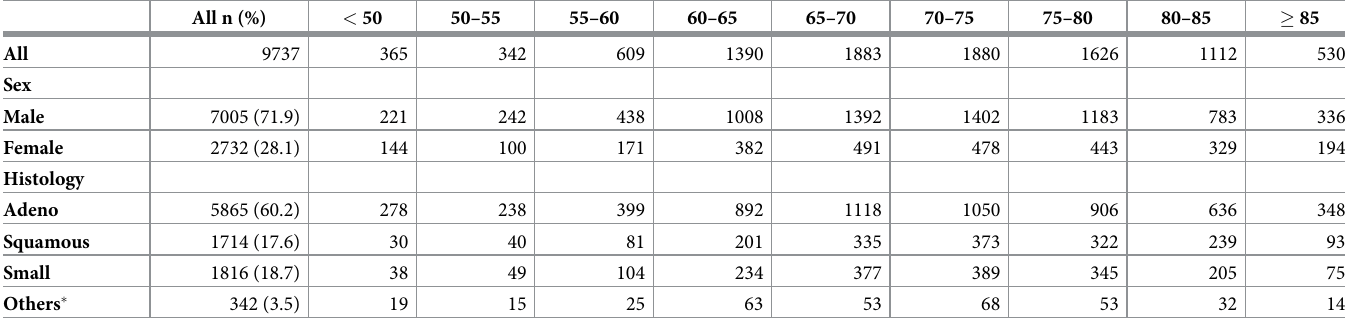
Table 1. Patient characteristics of each age